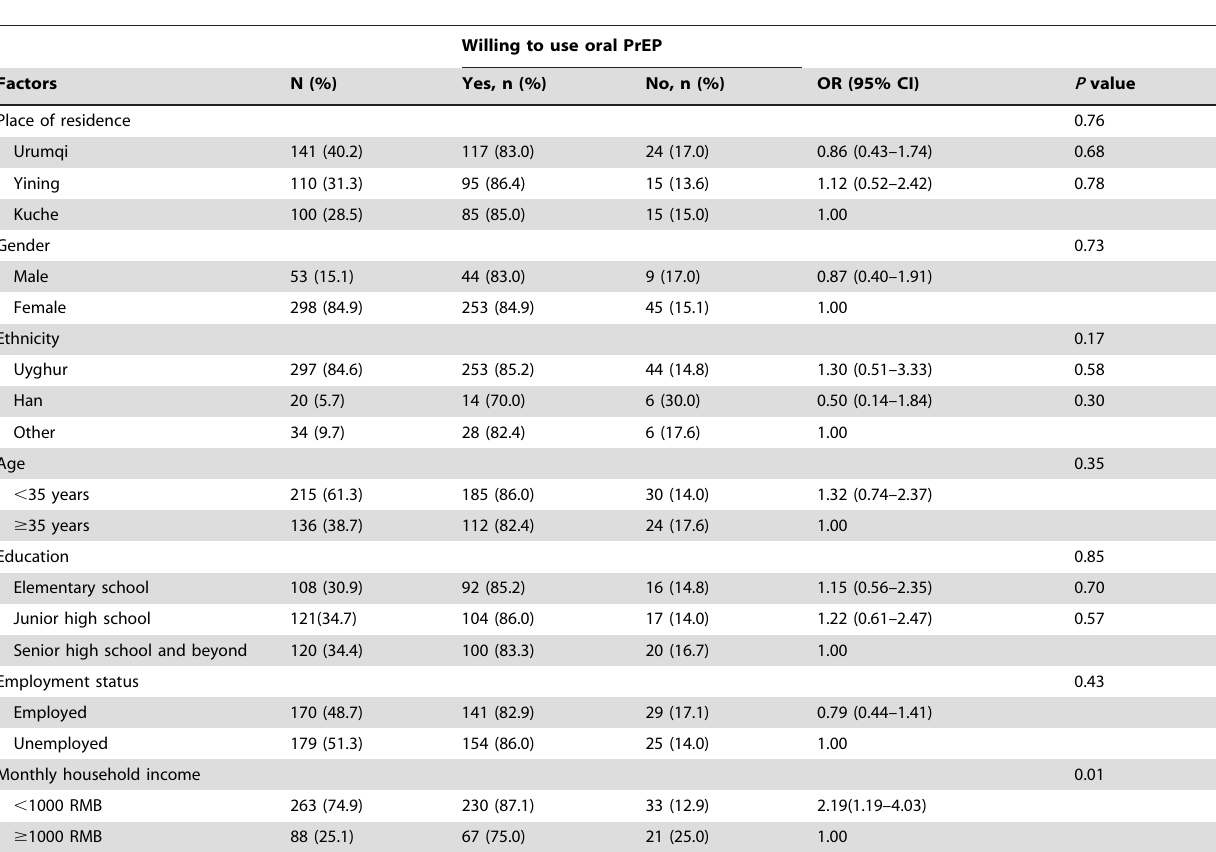
Table 1. Relationship between demographic characteristics and willingness to use oral PrEP.